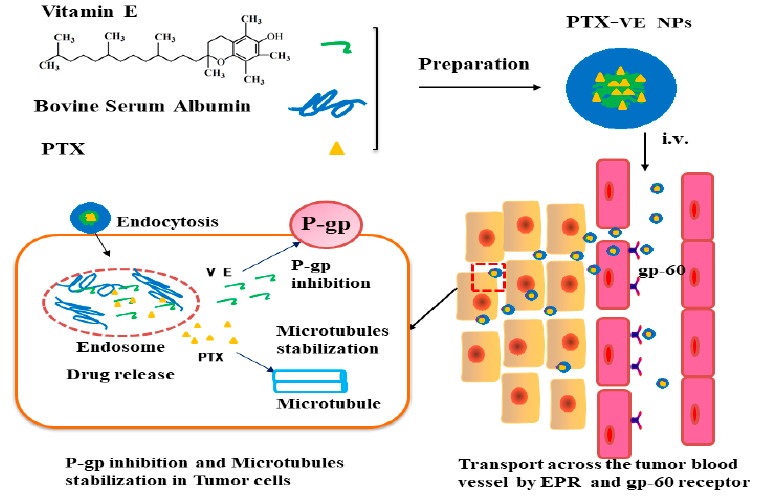
Figure 7. Schematic illustration of the PTX-VE NPs to reversal of MDR.